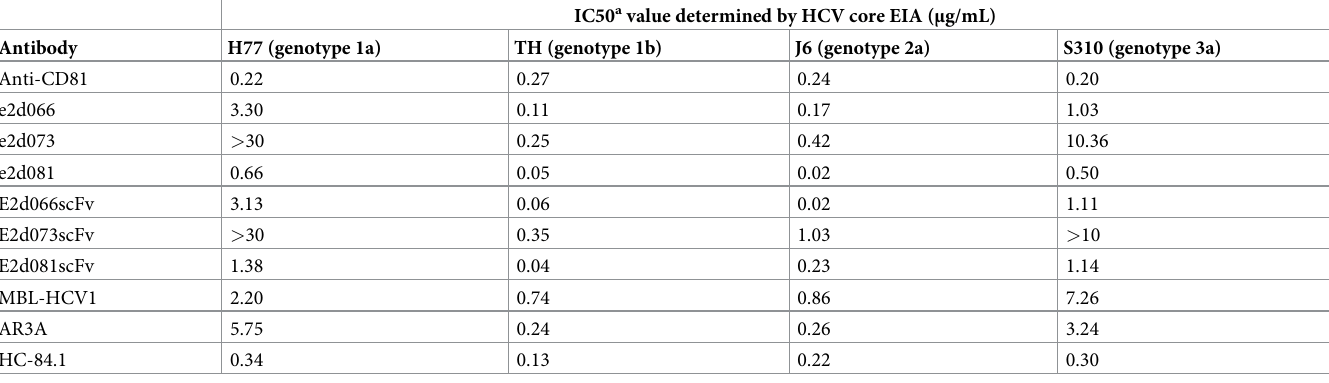
Table 2. IC50 values of antibodies against HCVcc infection, as determined by HCV core